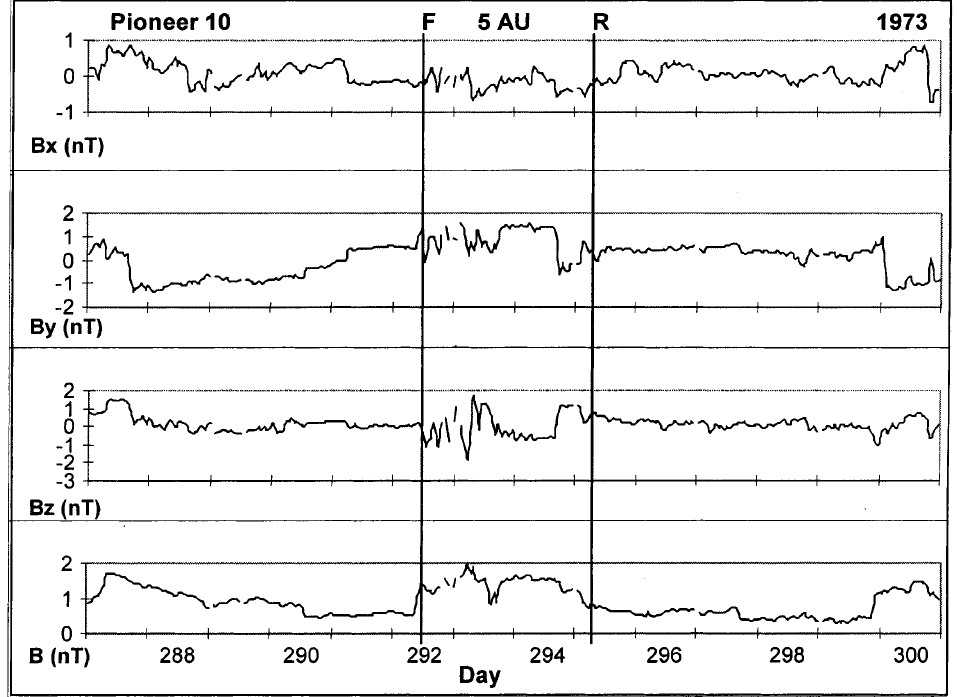
Fig. 1. Cartesian components and magnitude of the IMF measured by the Pioneer 10 at 5 UA. We present hourly averages. The forward shock of the CIR ( F ) appears about 11:15 on day 292, while the reverse shock ( R ) is around 03:20 on